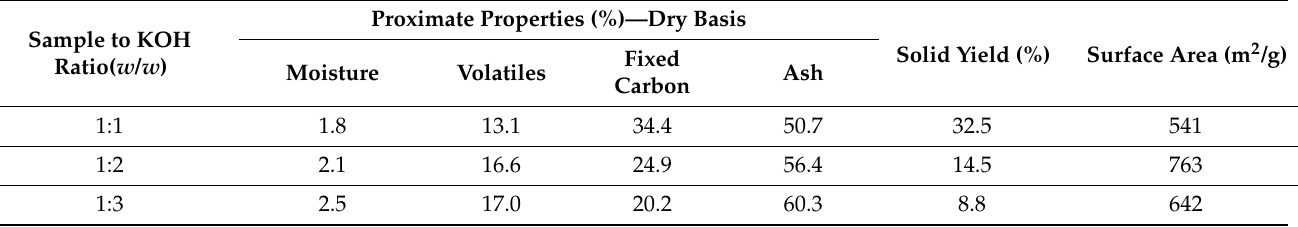
Table 3. Physical properties and the results of chemical activation on